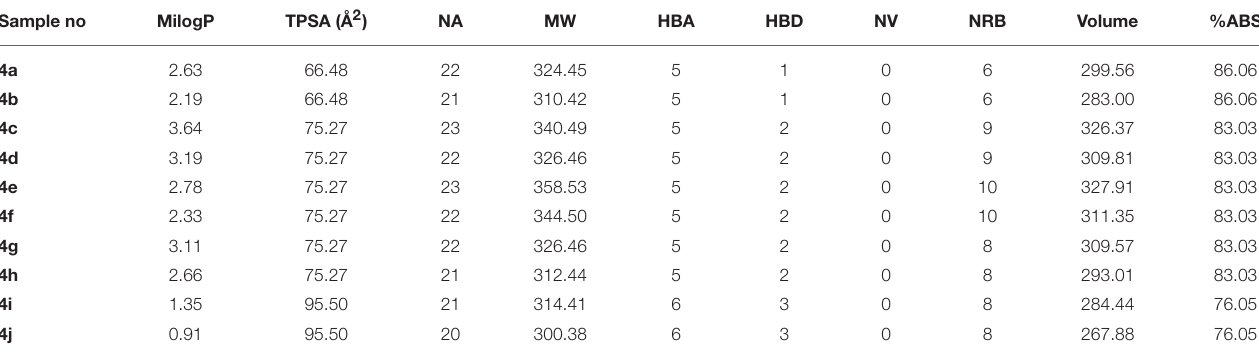
TABLE 7 | Physicochemical properties of the compounds. Sample